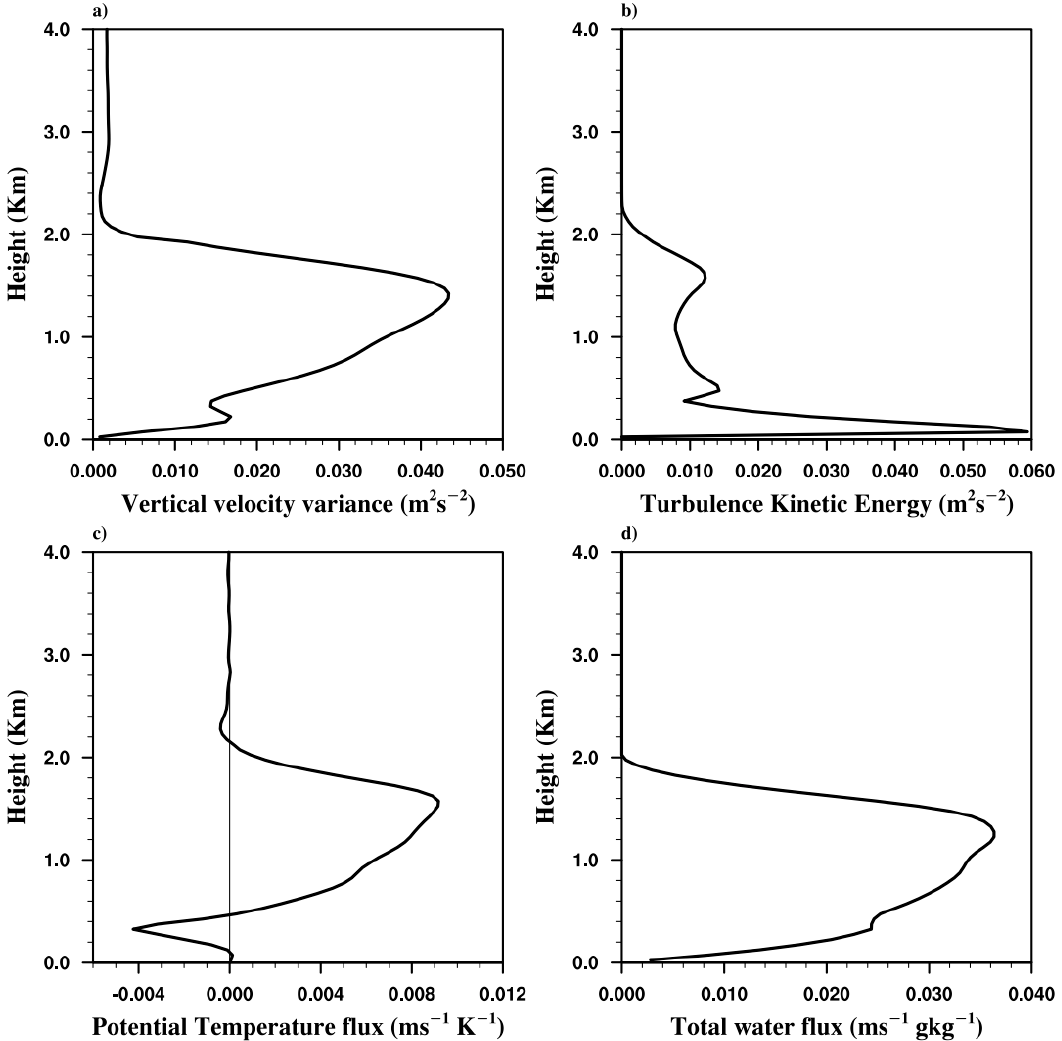
Figure 4. Turbulence characteristics profiles of: ( a ) vertical velocity variance; ( b ) turbulence kinetic energy; ( c ) potential temperature flux; and ( d ) total water flux.